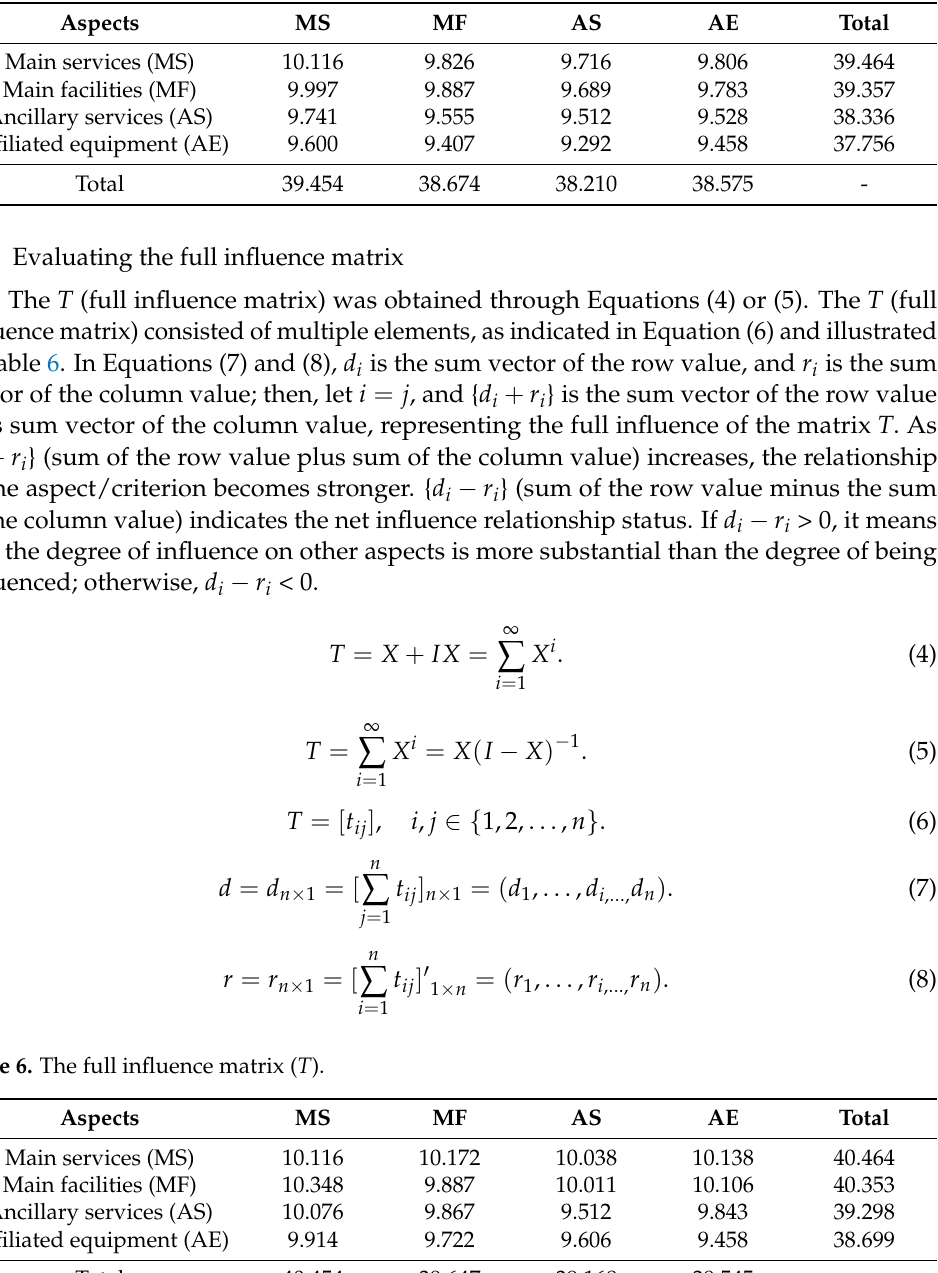
Table 5. The indirect influence matrix ( IX ).